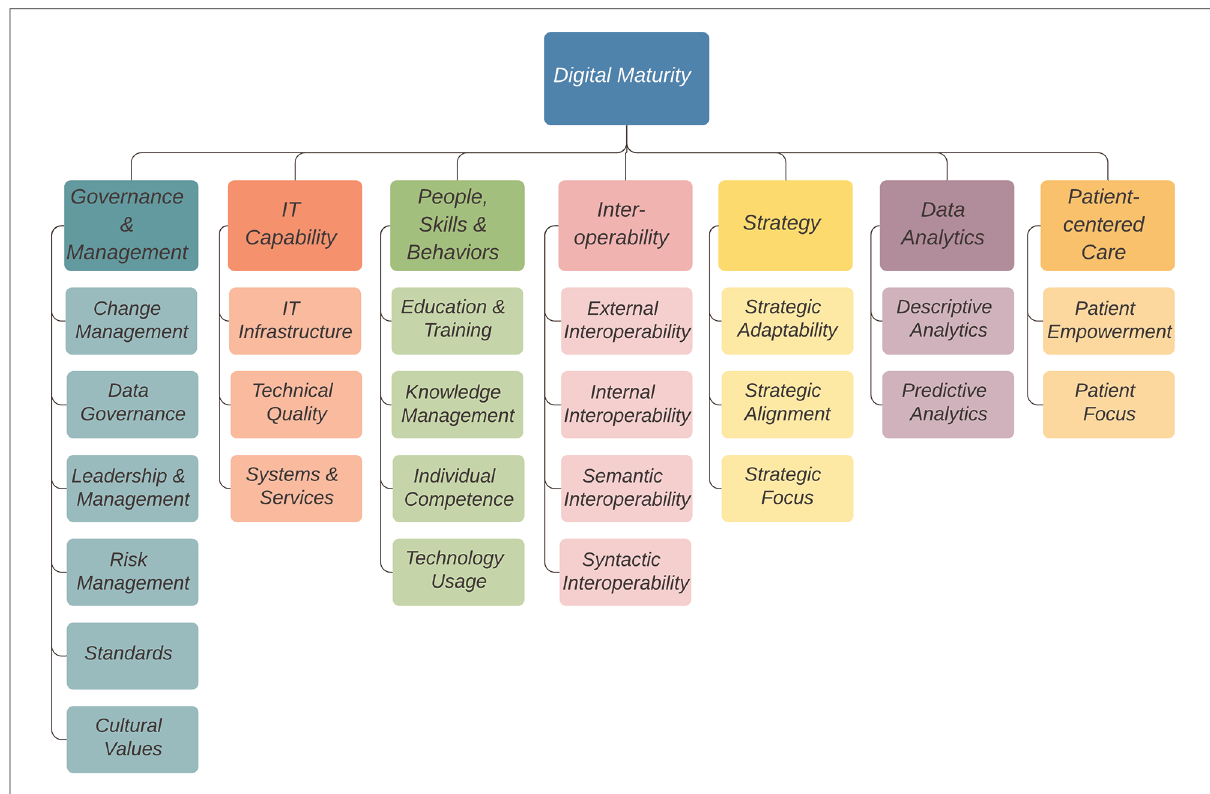
FIGURE 2 Digital maturity dimensions and corresponding indicators elicited from the